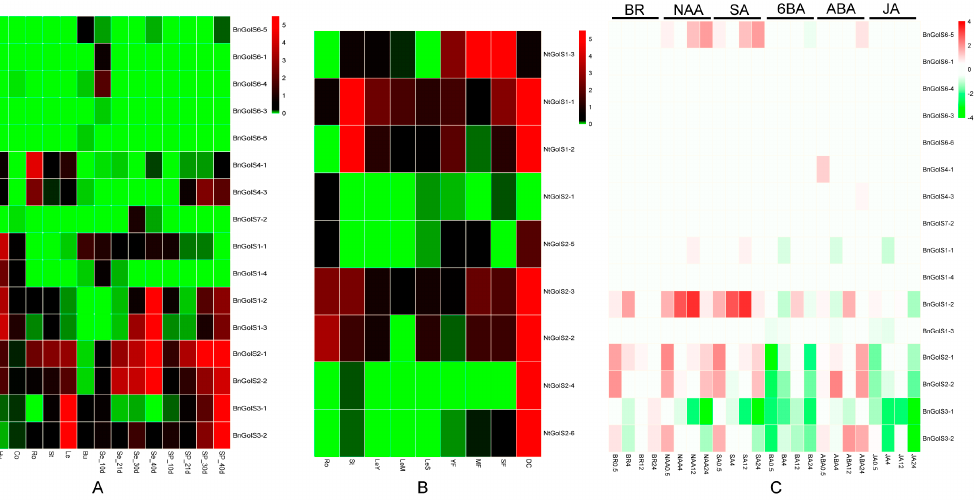
Figure 7. Tissue-specific and hormone-induced expression patterns of BnGolS and NtGolS genes. ( A ) Expression profiles of BnGolS genes in B. napus ; ( B ) Expression profiles of NtGolS genes in N. tabacum ; ( C ) Expression profiles of BnGolS genes in response to hormone treatments. The color bar to the right of the figures represents the log 2 expression value and the green color represents the low or no expression in ( A ) and ( B ) while it represents the down-regulation in hormone treatment in ( C ). To investigate the roles of the GolS genes in response to hormone treatments, rapeseed seedlings were subjected to brassinosteroid (BR), α -naphthaleneacetic acid (NAA), salicylic acid (SA), 6-